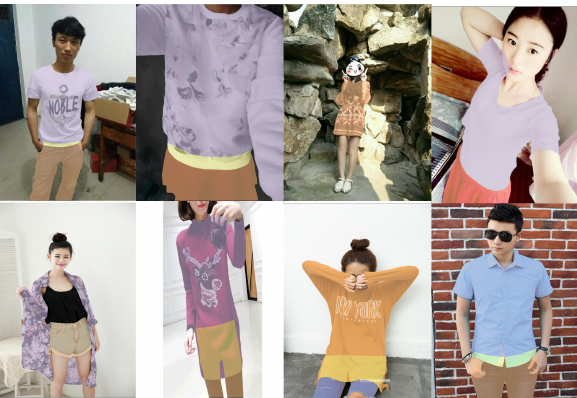
Figure 3. Some images from DeepFashion2 dataset. For each image, a segmentation mask of the clothes is given.